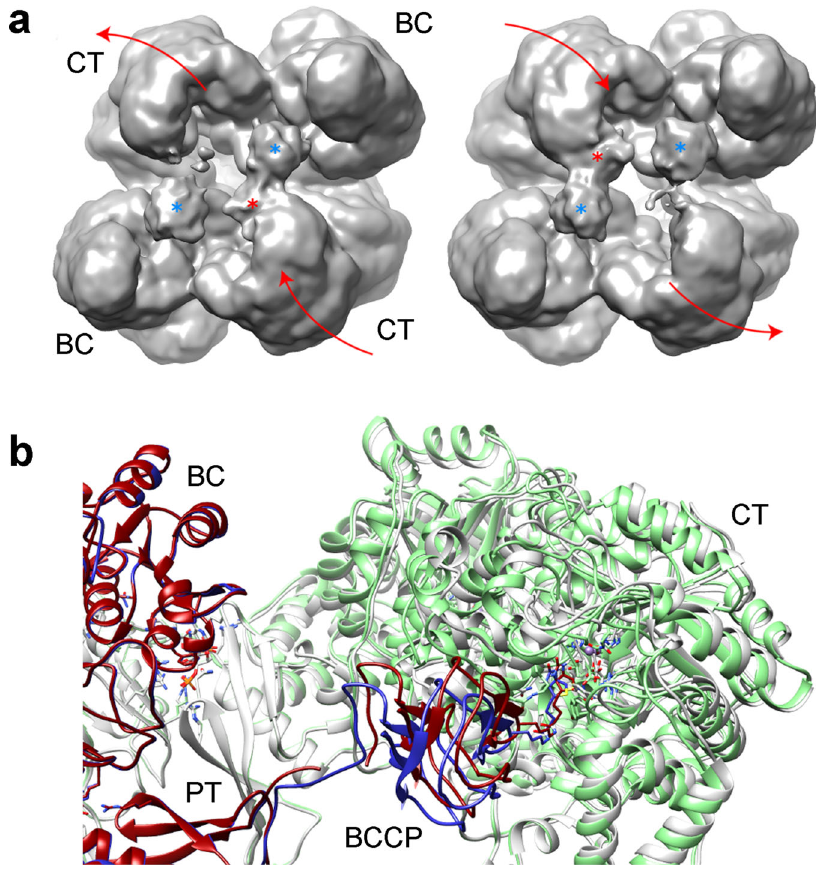
Fig. 9 | Correlation between CT tilt movement and occupancy of the CT site by BCCP. a Cryo-EM densities of LlPC obtained from 5% of particles at the beginning (left) or the end (right) of vector 4. The volumes have been fi ltered to improve the densityforBCCPdomainsandtheyarerenderedat1.1 σ ofdensitythreshold.Vector 4 corresponds to CT tilt and the movement has been highlighted with red arrows. BCCPshavebeenmarkedwithasterisks,blueiftheyinteractwithBCdomainorred